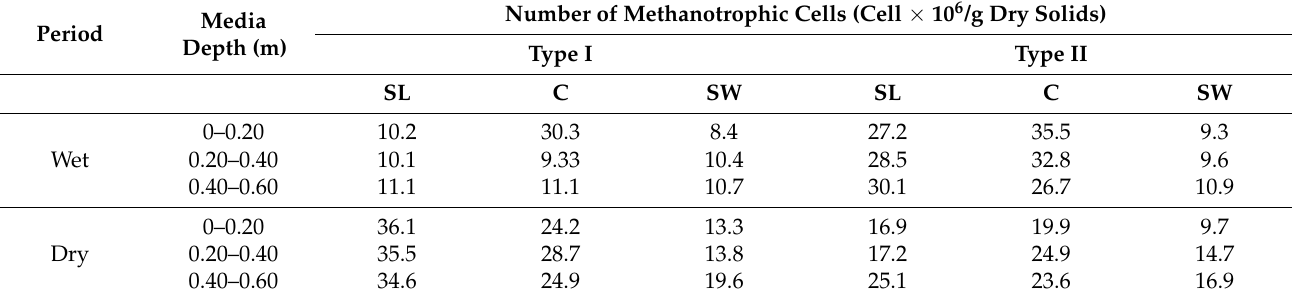
Table 5. Methanotroph population in the bio-cover